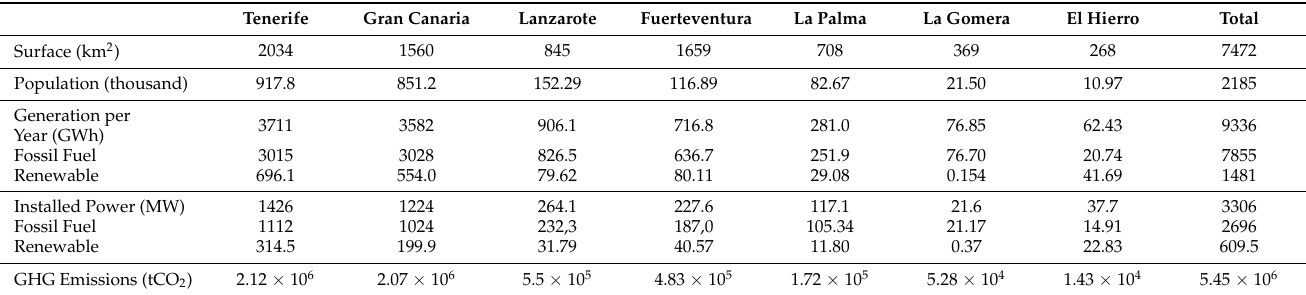
Table 1. General data and power details of the Canary Archipelago.